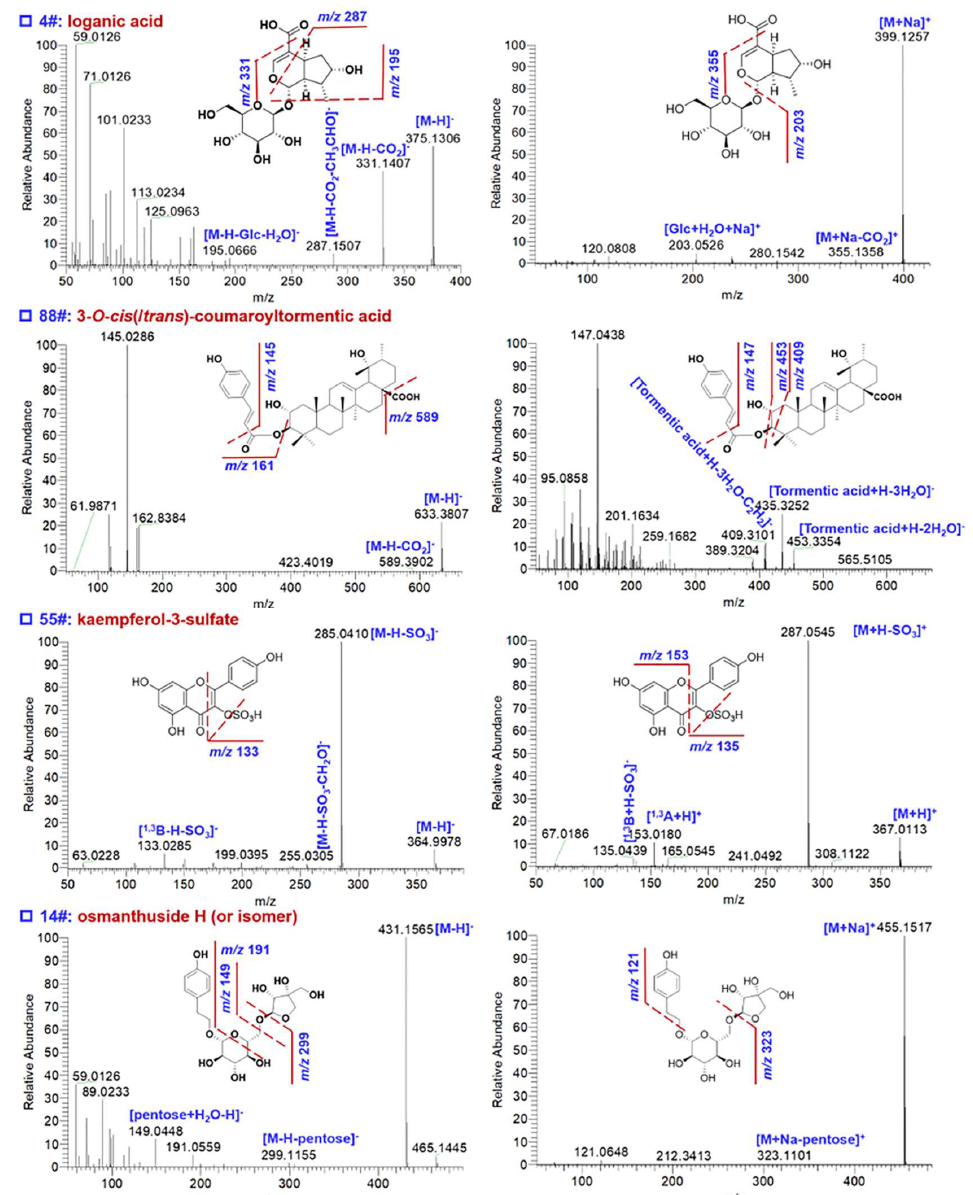
Figure 4. Fragmentation pathway analysis of four unknown compounds ( 4 #: iridoid; 88 #: triterpenoid; 55 #: flavonoid; 14 #: phenylethanol) profiled from EZP based on the negative and positive HCD-MS 2 data.